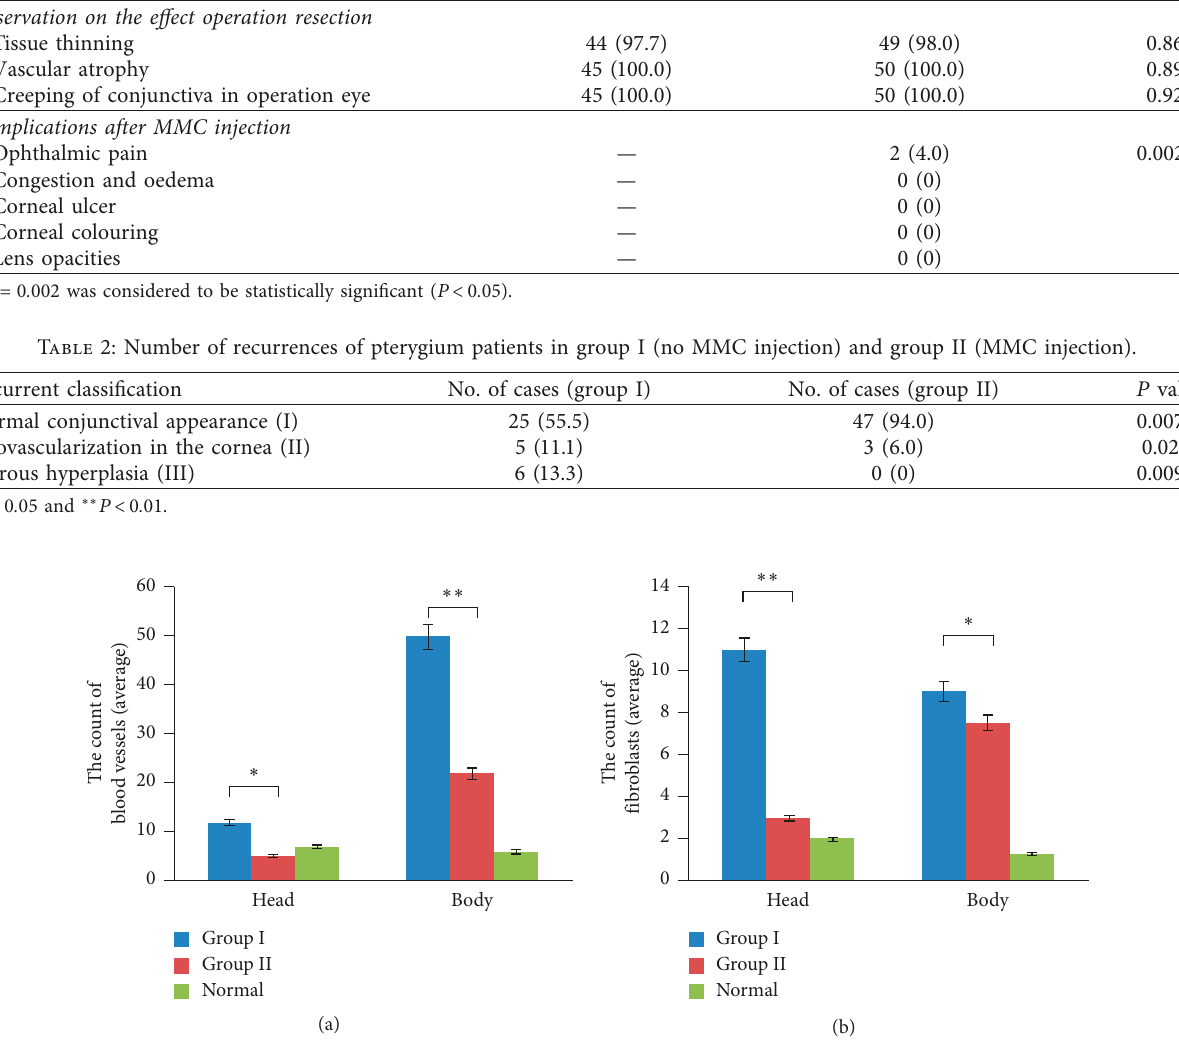
Figure 1: MMC inhibits corneal neovascularization and the proliferation of fibroblasts in pterygium tissues. (a, b) The number of blood vessels (a) and fibroblasts (b) in pterygium samples from group I and group II patients was counted under optical microscope after histochemical analysis ( × 400). Mean value of per field was shown (five randomly selected visual fields). Data are expressed as the means ± SD of three samples per group. ∗ P < 0 . 05 and ∗∗ P < 0 . 01. Normal corneal tissues serve as controls.